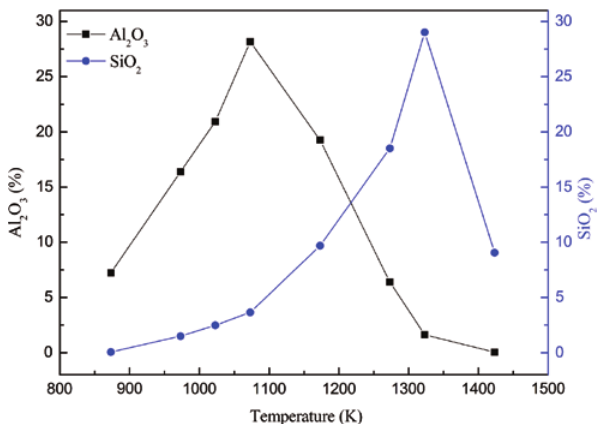
Figure 1: The contents of active components at different calcination temperatures.